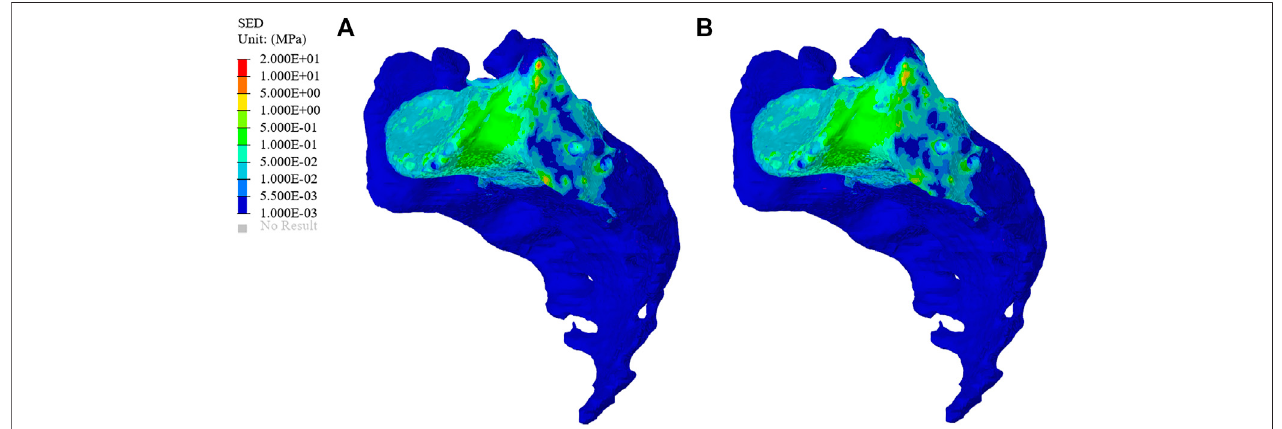
FIGURE8| Distribution ofsacral strainenergy density (SED)intheoriginalgroupandoptimized group. (A) TheSEDdistributionofthesacrumintheoriginalgroup. (B) The SED distribution of the sacrum in the optimization group.